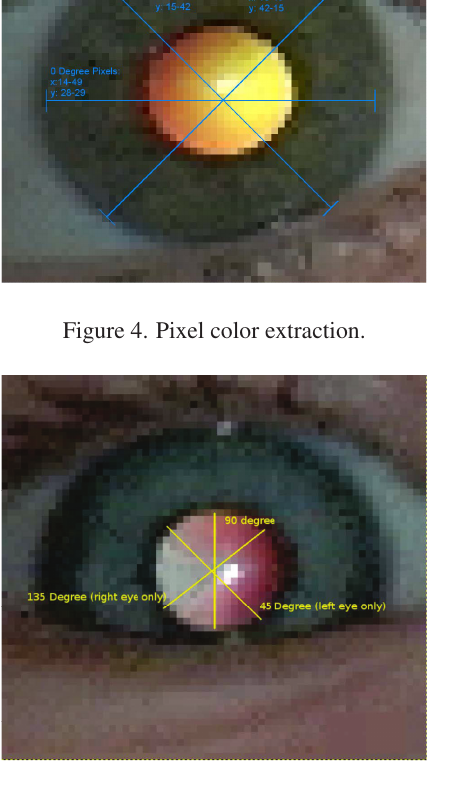
Figure 5. Phases two and three pixel color